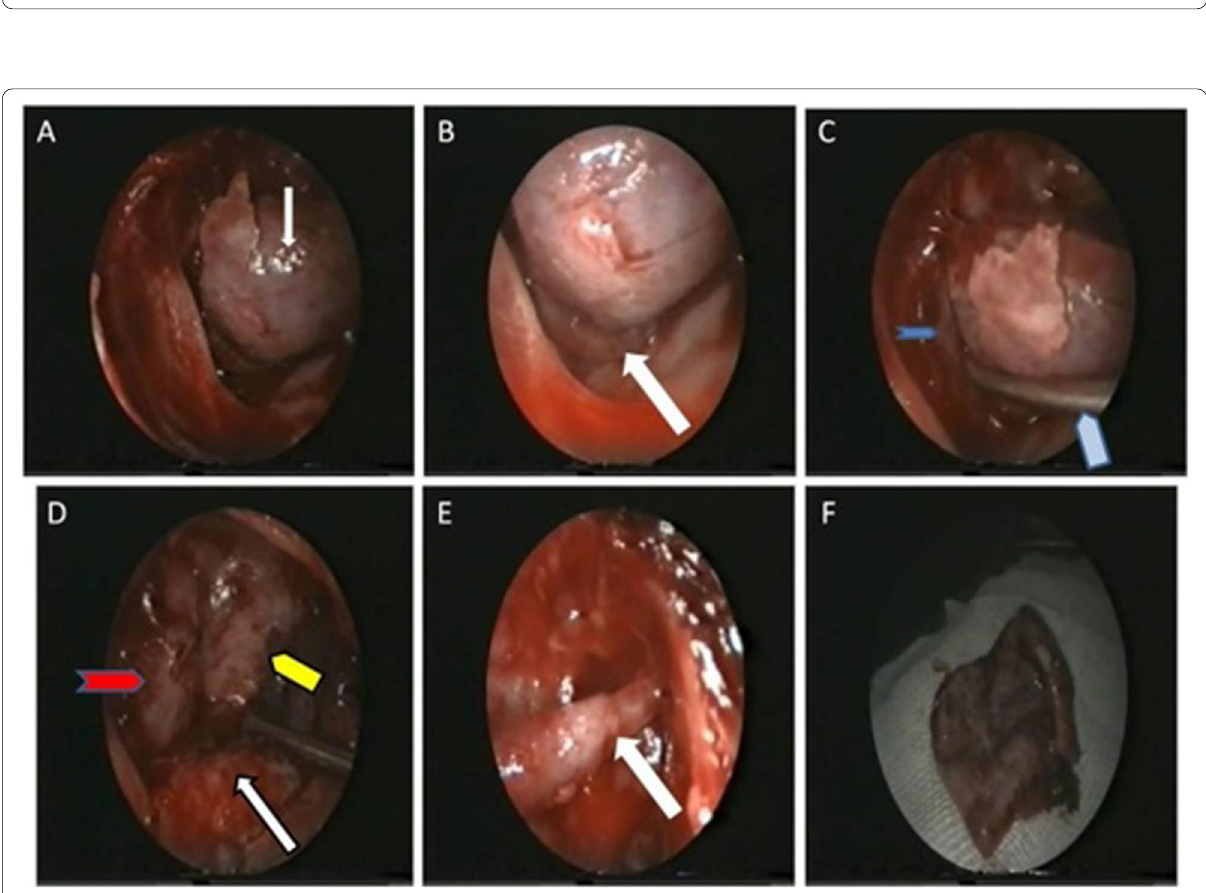
Fig. 2 CT scan of lesions enucleated endoscopically via trans-nasal approaches. A Calcifying odontogenic tumor (white arrow) excised via endoscopic endonasal minimal rhinotomy. B Right periapical maxillary intra-sinus cyst with scalloping of the maxillary sinus walls (white arrow) enucleated via endoscopic wide middle meatal antrostomy